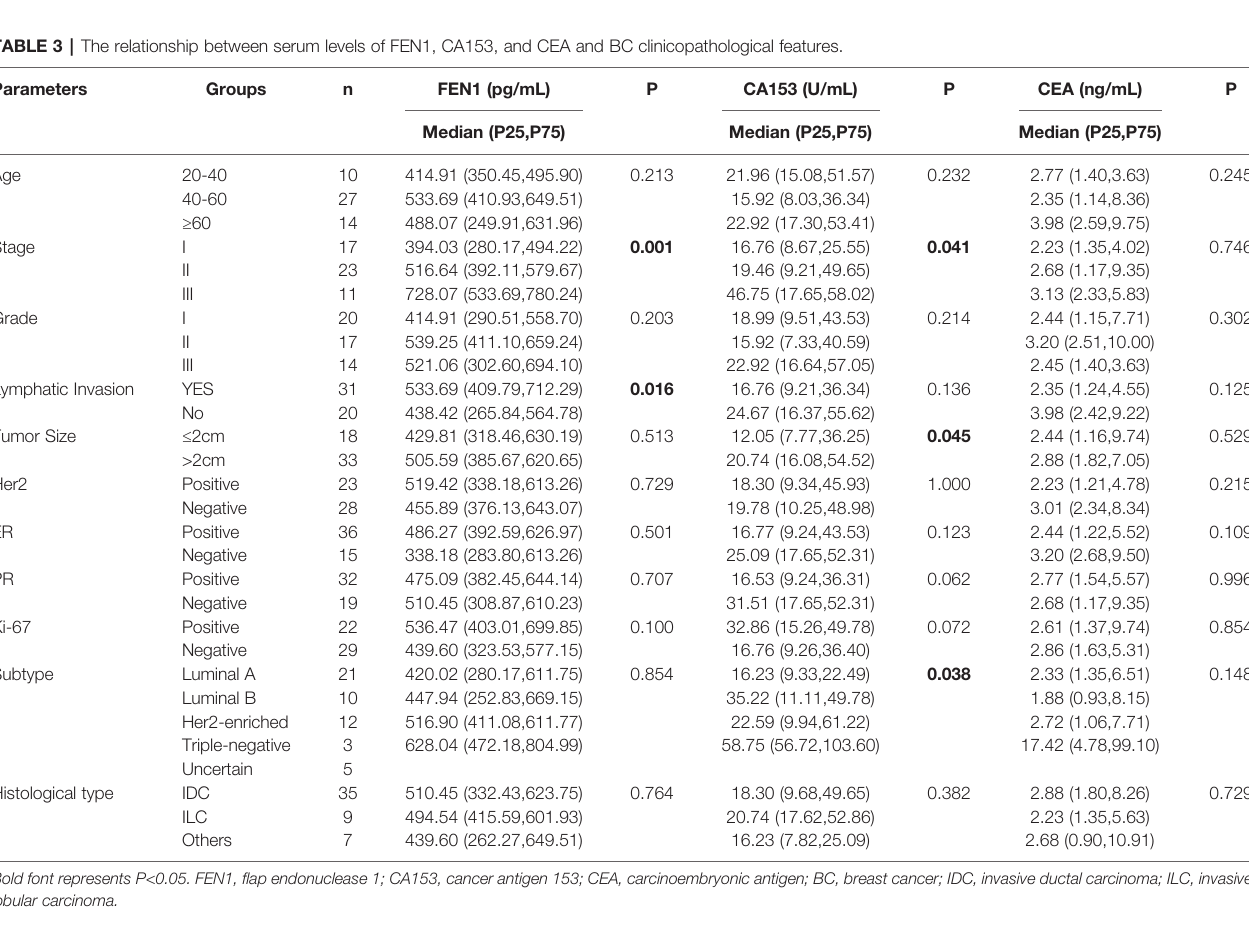
prognosis of BC patients. The survival analysis indicated that high FEN1 levels were associated with poor prognosis in BC, including OS, RFS, and DMFS ( Figure 7 ), revealing a promising